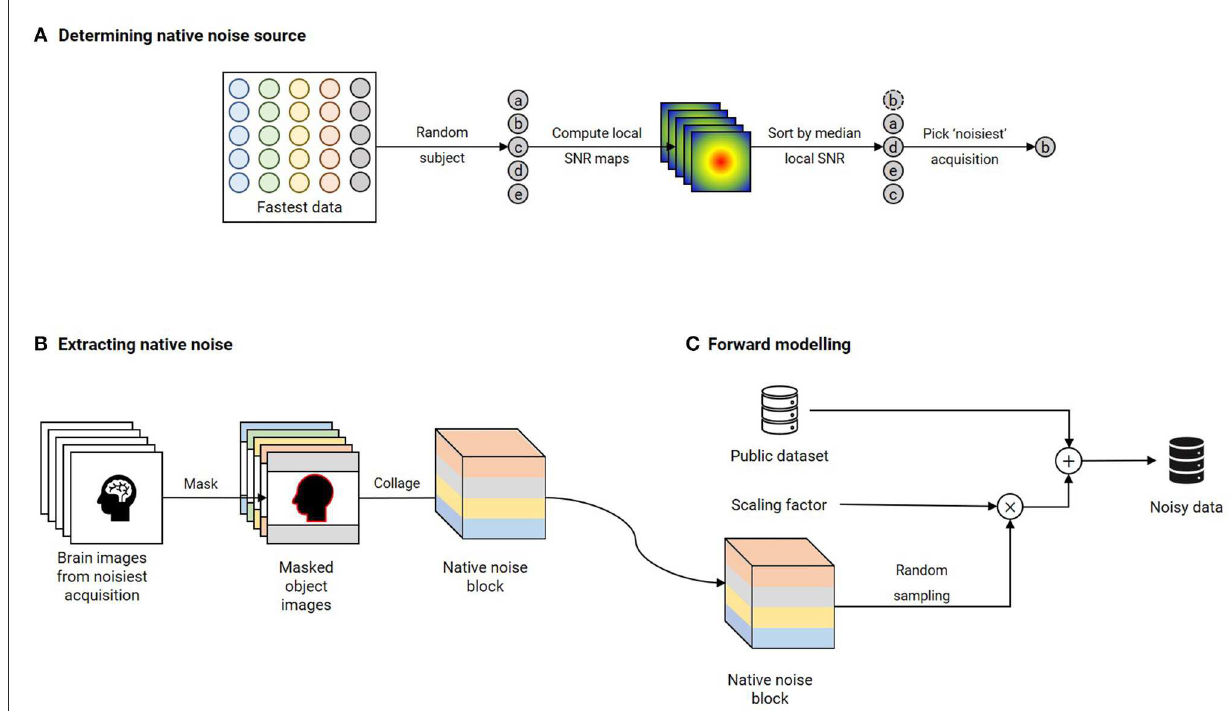
FIGURE2 Forward modeling of noisy data using native noise for each contrast. (A) A random subject’s acquisitions are chosen from the Fastest dataset. Brain-masked local SNR maps are computed, and these acquisitions are sorted in ascending order of median local SNR. The acquisition yielding the lowest value is chosen as the “noisiest” acquisition. (B) Native noise is extracted from this noisiest acquisition by assigning all non-object voxels as noise. These noise voxels are collaged to obtain a native noise block. (C) The noise-free public dataset is corrupted by native noise randomly sampled from the native noise block and scaled by a noise factor. This scaling factor is determined by iteratively incrementing from an initial value of 0.5 until the median brain-masked local SNR of a randomly chosen volume from the public dataset that is corrupted by native noise matches that